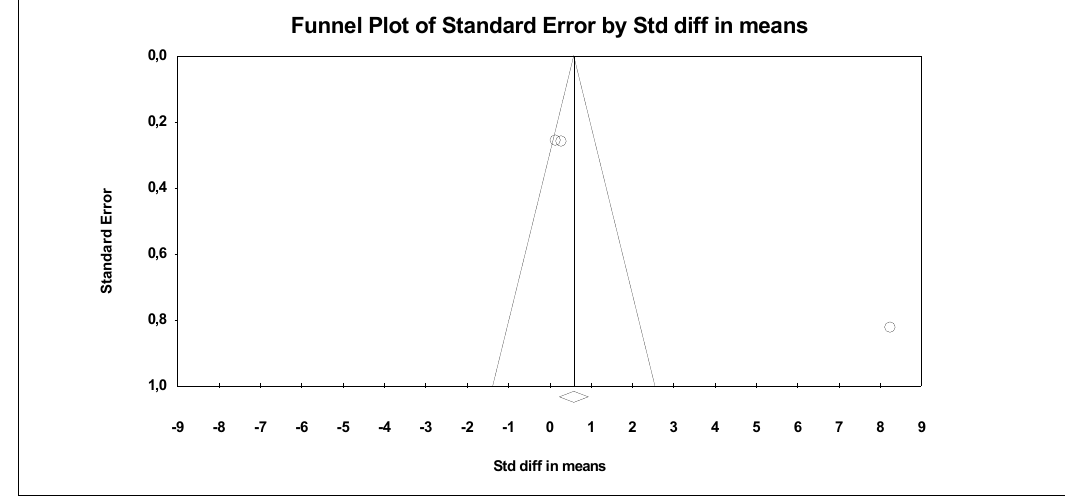
Figure 5. Funnel plot for endpoint TCA (SMD) in present meta-analysis.